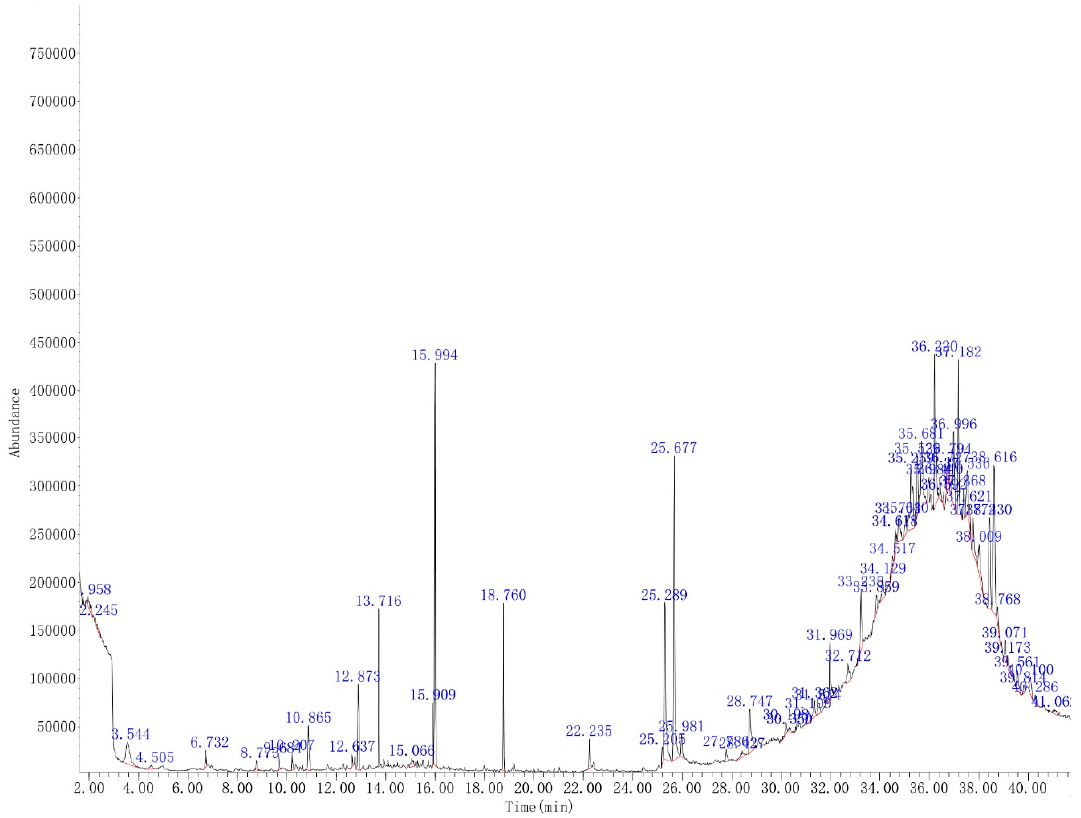
Figure 3. Total ion chromatograms (TIC) of unregulated emissions absorbed by activated carbon in conventional diesel combustion. Table 3. Exhaust components absorbed by activated carbon in conventional diesel combustion.